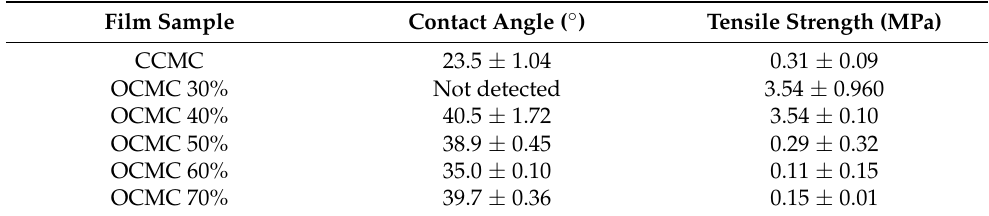
Figure 7. Contact angle images of CCMC film ( a ), OCMC film prepared with 40% ( b ), 50% ( c ), 60% ( d ) and 70% ( e ) NaOH within 3 h. Table 1. Contact angle value of and tensile strength of CMC films produced from OPEFB at different NaOH concentrations within 3